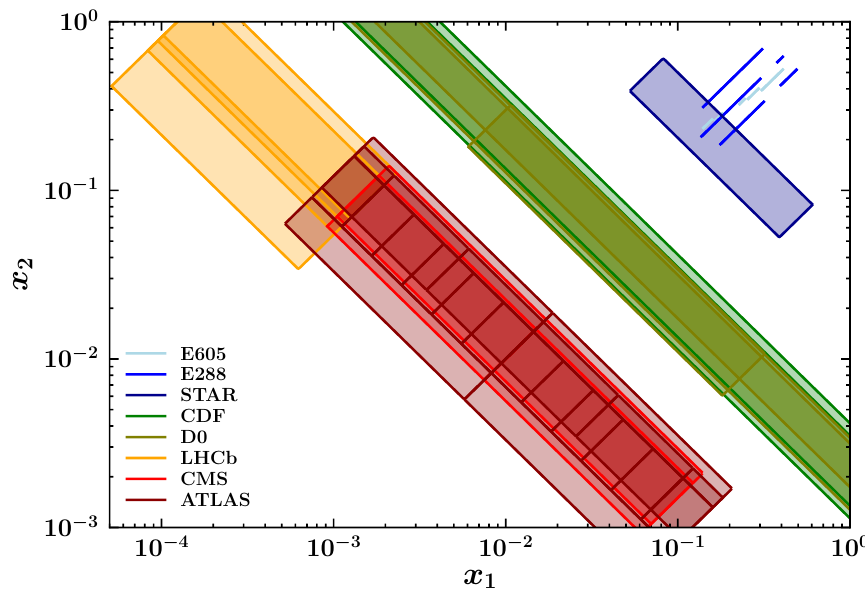
Figure 3 . Kinematic coverage on the x 1 vs. x 2 plane of the dataset included in the present